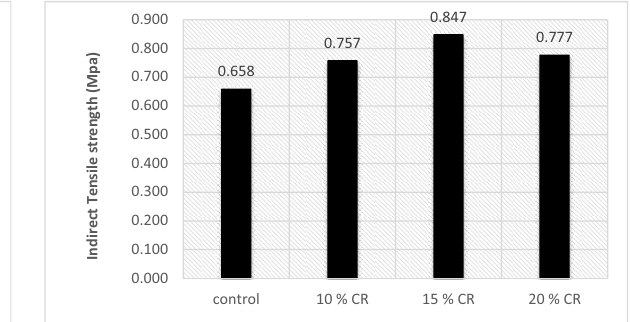
Figure 8: Results of the test ’ s drain down.